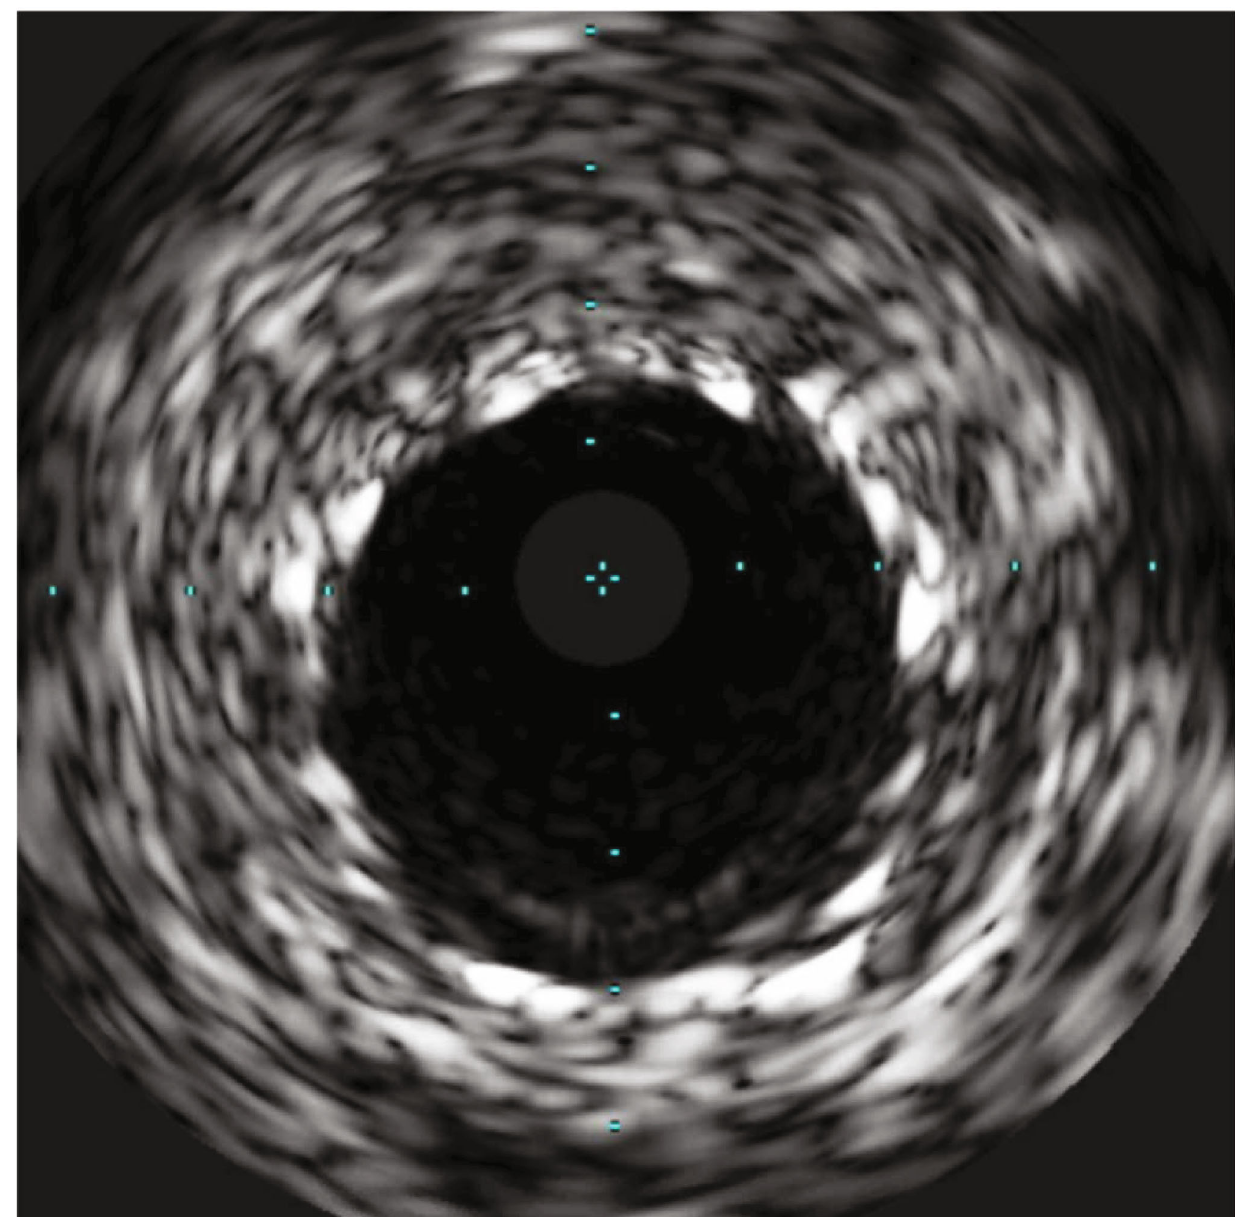
Figure 13: IVUS shows poststent, lumen diameter of over 4mm with excellent stent